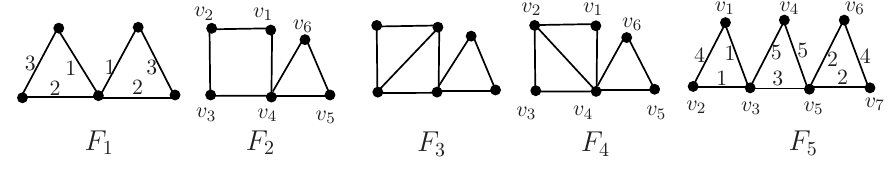
Figure 2: A graph in Theorem 5.33.